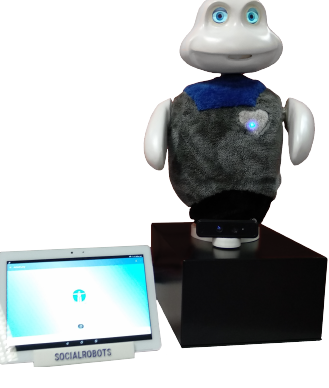
Figure 4. The social robot Mini.